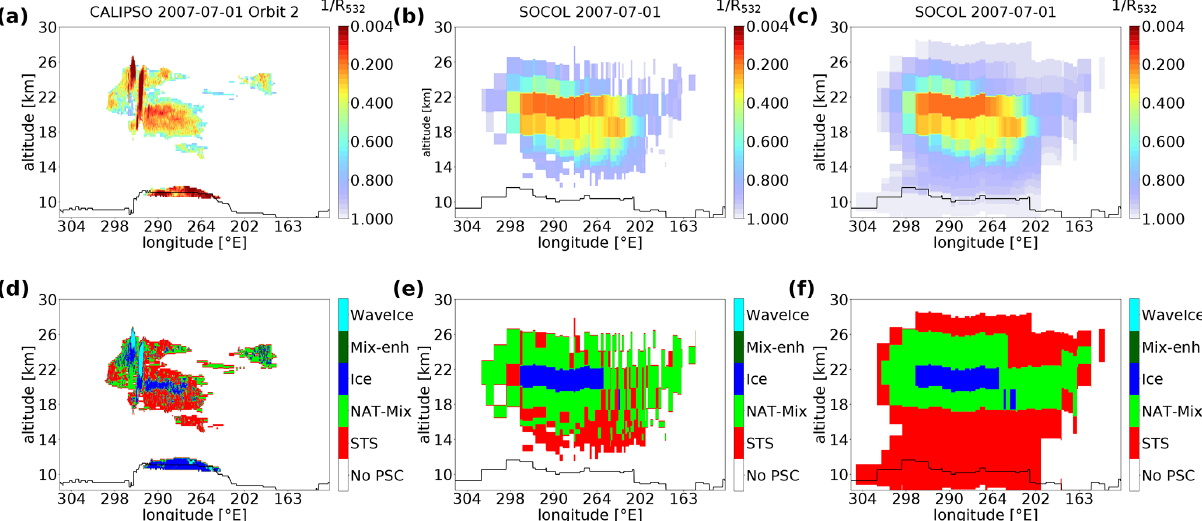
Figure 3. CALIPSO measurements on 1 July 2007 (orbit 2) of R 532 (a) and the PSC classification (d) . Calculated R 532 values for modeled PSCs from the simulation S REF in the overflown grid boxes after adding the instrument uncertainty and applying the detection thresholds are shown in (b) . Panel (e) shows the composition of the corresponding PSCs according to the classification scheme in Pitts et al. (2018). (c, f) The same as in (b) and (e) , but without instrument uncertainty and the detection thresholds. The black lines indicate the World Meteorological Organization (WMO) and model tropopause height for CALIPSO measurements and simulations,